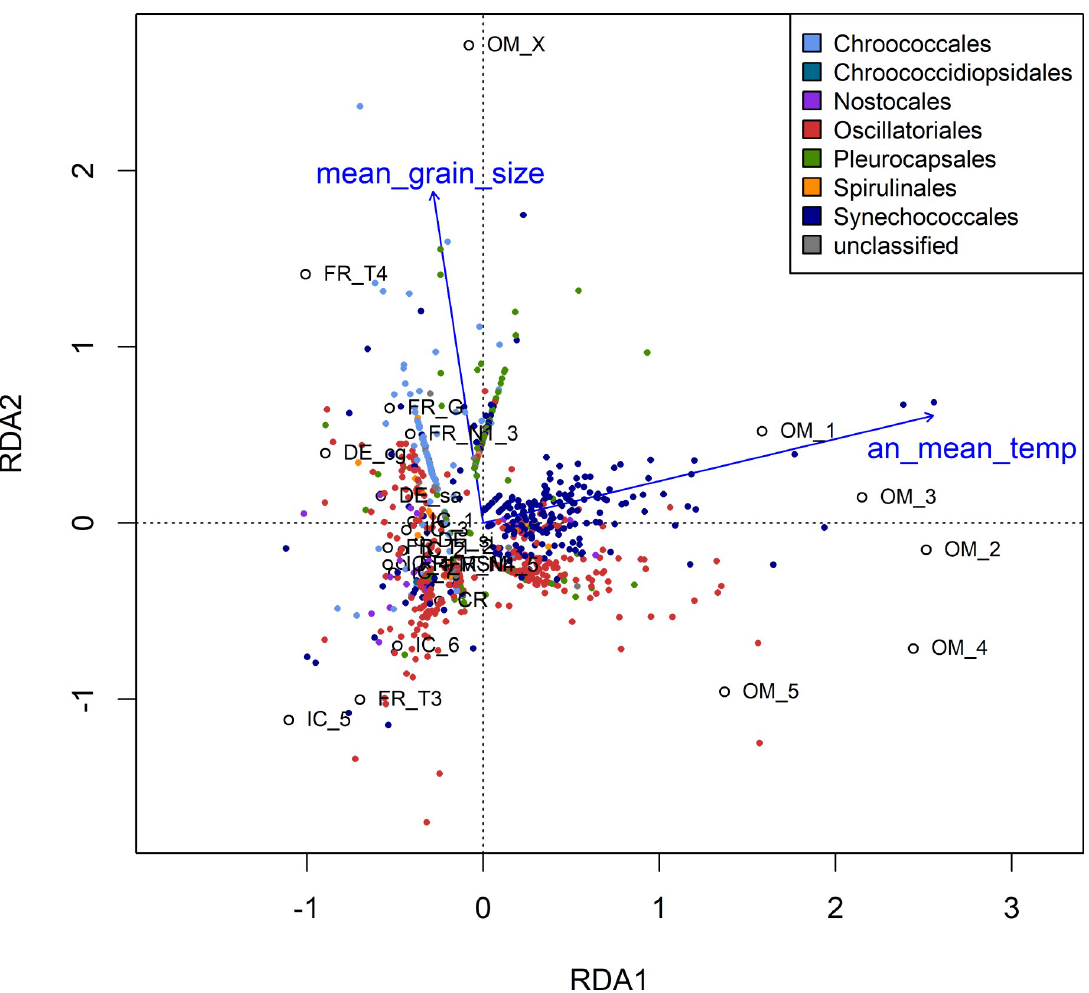
Fig 3. RDA analysis with forward model selection based on sequence numbers per OTU and a subset of non- or less-correlated abiotic parameters. Standardized values of annual mean temperature, mean grain size, pore water NH 4 /NO X /PO 4 ; IC = Iceland, DE = Germany, FR = France, CR = Croatia, OM = Oman; RDA1 axis explains 13%, RDA2 axis 7% of the variance. Total and pure effects of the environmental parameters are provided as Supplementary Information (S6 Table).